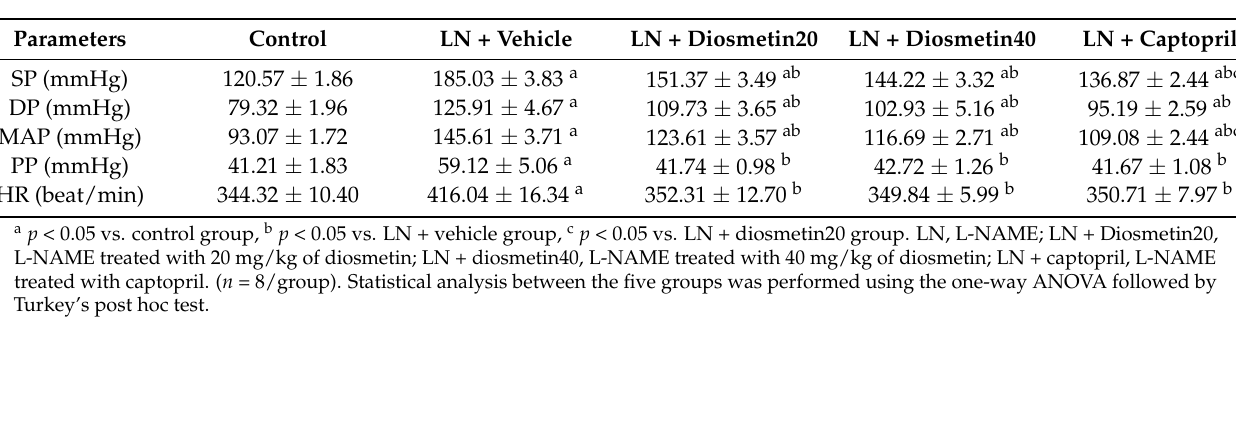
Table 1. Hemodynamic parameters under anesthetization in all experimental groups.